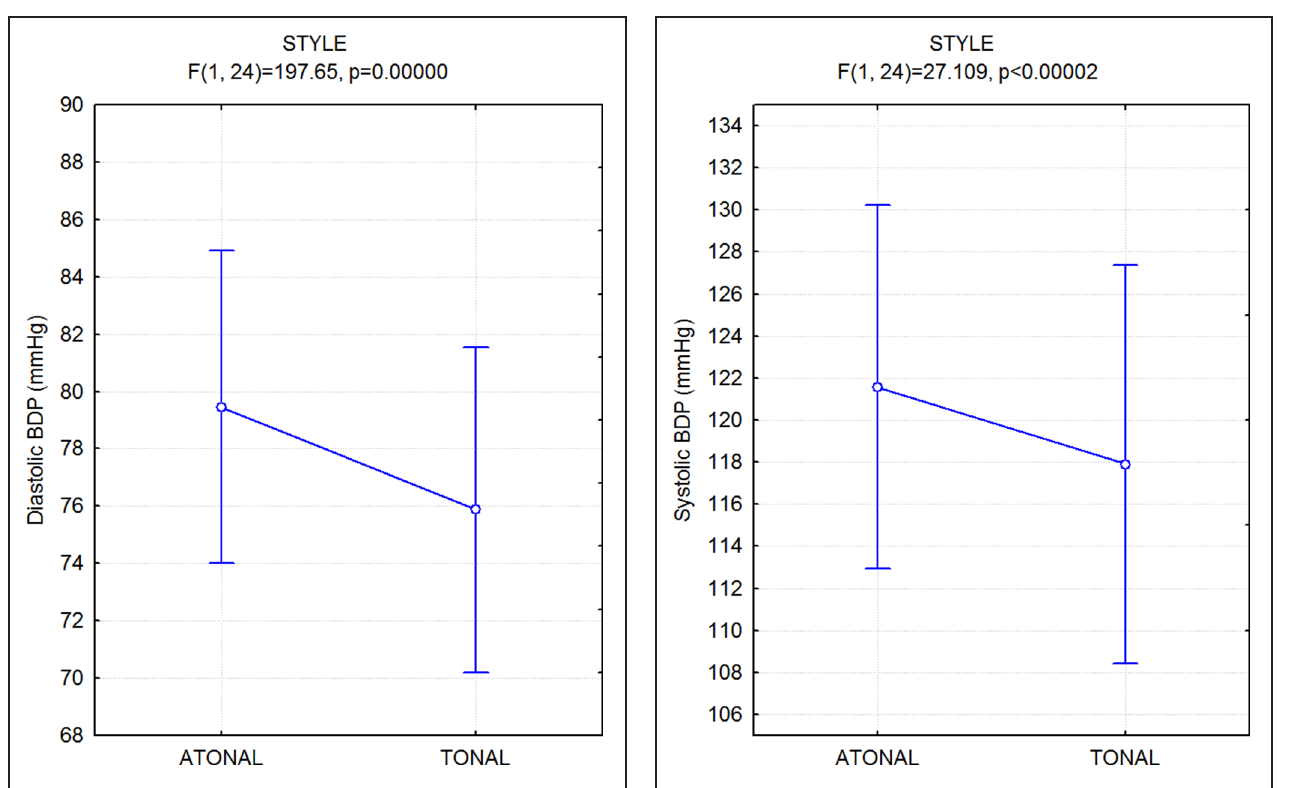
FIGURE 6 | Mean values of diastolic blood pressure (diaBDP), along with standard errors, recorded while participants listened to atonal vs. tonal music pieces.